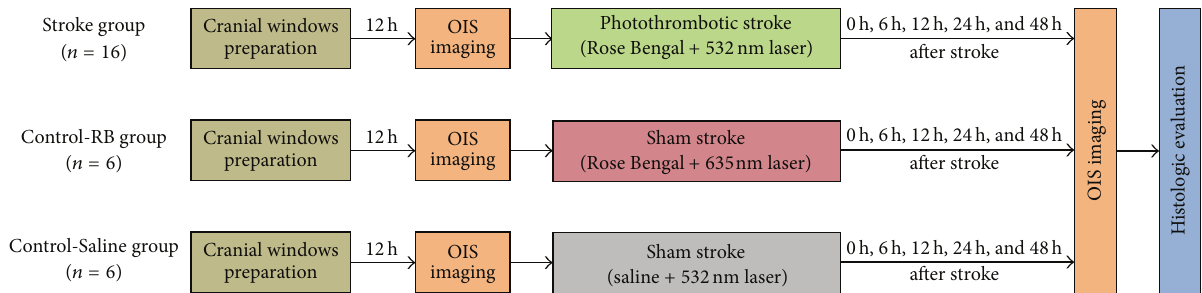
Figure1:Experimentalprotocols.InStrokegroup,thecranialimagingwindowswereprepared12 hbeforethestrokesurgery.Opticalintrinsic signal (OIS) images were recorded for assessing the somatosensory response at different stages of the experiment (baseline before stroke, and 0 h, 6 h, 12h, 24 h, and 48h after stroke). Histologic analysis was performed to confirm the lesion after the experiment. Different from Stroke group, the two Control groups underwent sham surgery instead of photothrombotic stroke. Considering the potential influence of the Rose Bengal or laser illumination, we included two Control groups (Control-RB and Control-Saline). Control-RB rats were illuminated by nonresponsive red laser ( 635 ± 5 nm, 20 mW), while Control-Saline rats were injected with the same dosage of